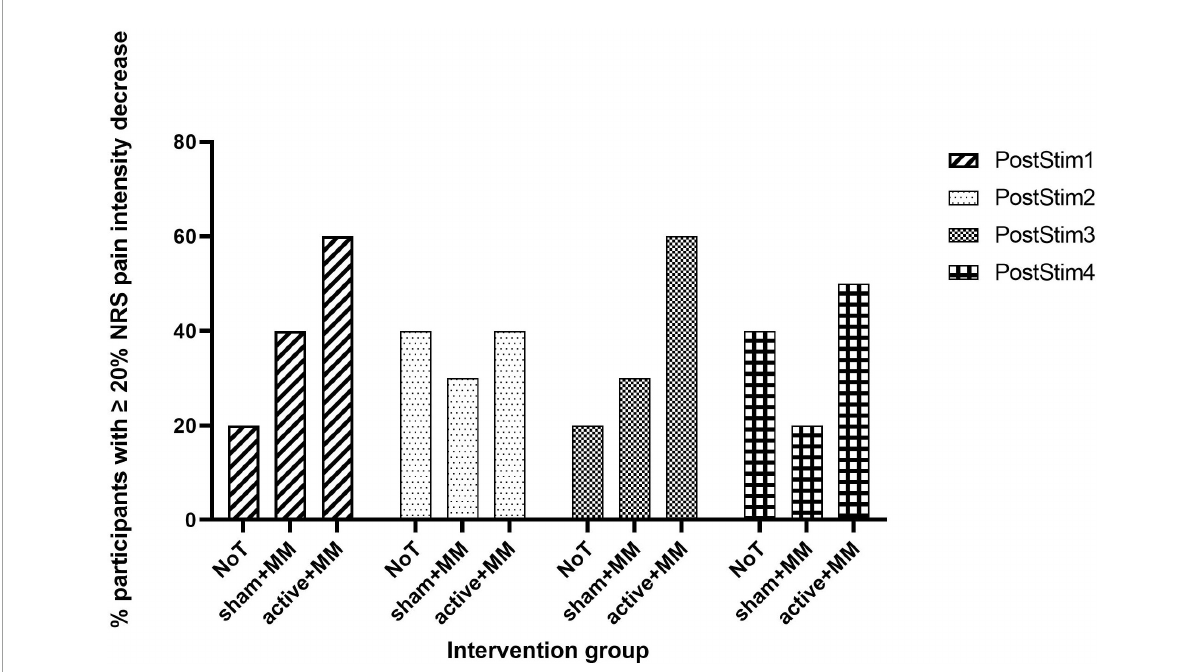
FIGURE4 Clinically meaningful pain relief. Bar chart illustrating the percentage of participants who reported ≥ 20% reduction in NRS pain intensity at each follow-up post stimulation week compared to baseline in the NoT, sham + MM and active + MM